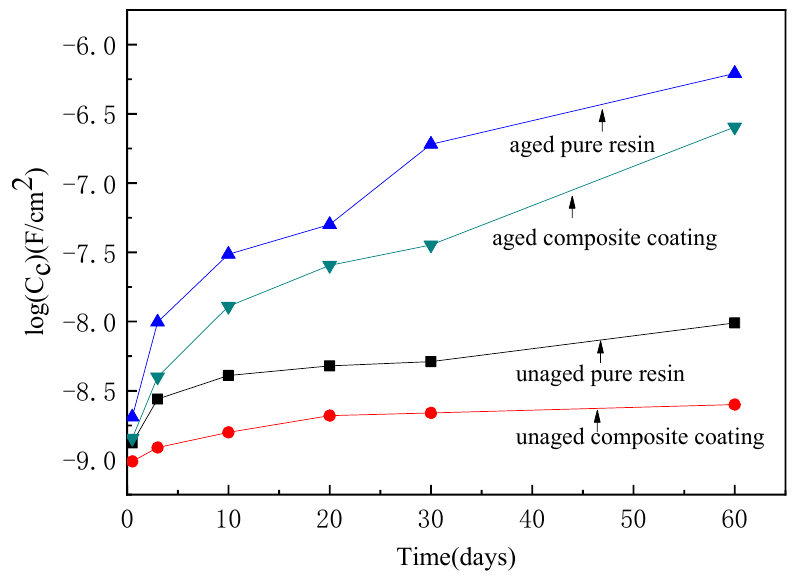
Figure 12. The coating capacitance variation of pure epoxy resin and composite with time.